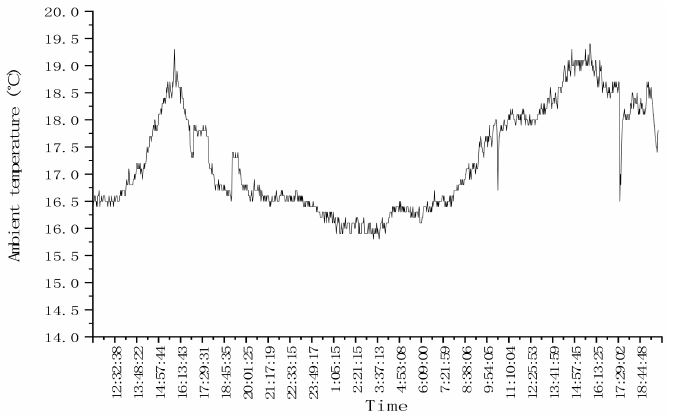
Figure 12. Variation of ambient temperature with time in the drying process.